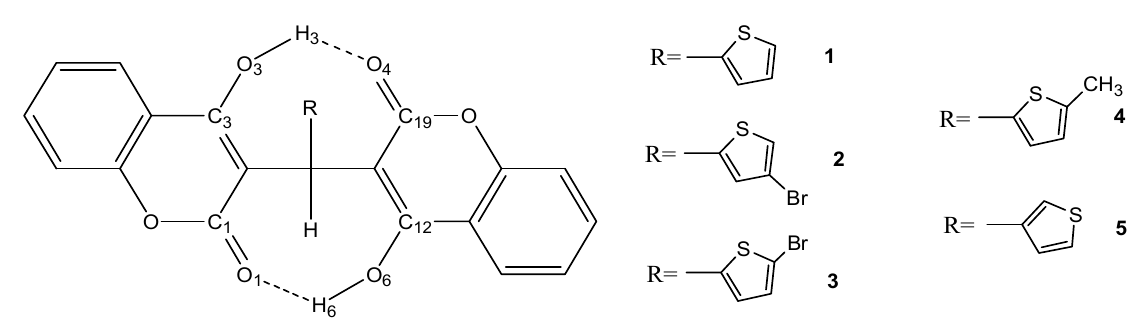
Figure 3. Schematic representation of compounds 1 – 5 .